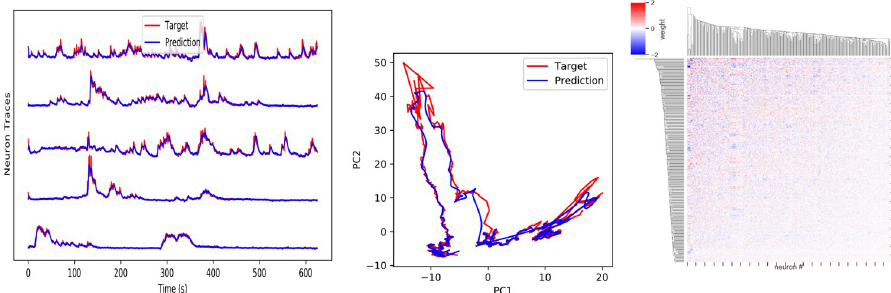
Fig 8. Reproducing neural dynamics recorded from larval zebrafish subpallium. (A) Target and network output for 5 example neurons after training ends. (B) Target and predicted trajectories of the trained network projected onto the first 2 PCs. (C) Learned effective weight